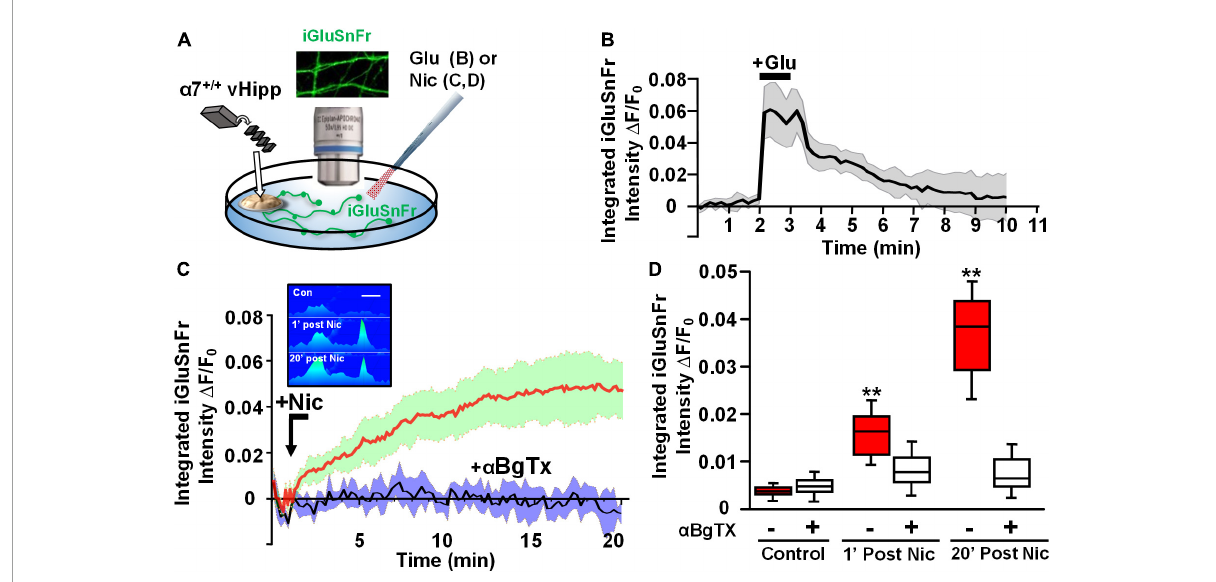
FIGURE5 Axonal α 7* nAChRs are required for nicotine-evoked glutamate release along ventral hippocampal projections. Nicotinic modulation of glutamatergic signaling along vHipp axons. (A) Schematic diagram of experimental configuration, see Section “Materials and methods.” In these studies, vHipp from individual WT ( α 7+/+) mice were plated as thinned micro explants in iGluSnFr (AAV9.hSyn. iGluSnFr.WPRE .SV40) containing culture media (see Section “Materials and methods”). After 7–10 days in vitro , iGluSnFr fluorescence signals along the vHipp axonal projections were recorded as an assay of glutamate release. Representative images of iGluSnFr expressing axons are shown. (B) iGluSnFr fluorescence intensities were calculated from spinning disk confocal images of α 7+/+ vHipp axons, collected every 10 s for 10 min and quantified as a normalized integrated intensity at each time point. The percentage changes in normalized integrated intensity at individual 1- µ m spots along vHipp axons were plotted vs. time. Traces from α 7+/+ vHipp axons are shown before, during and after glutamate-application (averaged of two recordings from two separate experiments). Application of exogenous glutamate (100 µ M, 1 min) increased iGluSnFr fluorescence intensity by ∼ 7%; this increase is maintained during glutamate application and decays to baseline over the next 5 min after glutamate wash out. Glutamate applications at lower concentrations did not show significant increase of iGluSnFr fluorescence intensities (data not shown). (C) Averaged traces of normalized iGluSnFr intensity along α 7+/+ vHipp axons before and after exposure to nicotine. Under normal conditions a 1 min exposure to nicotine elicited a robust increase in iGluSnFr signal along the vHipp axon, consistent with detection of local release glutamate (red line; SD = green shading, n = 20, 3). The effects of α BgTx treatment – which blocks all detectable nicotine induced iGluSnFr signal – is shown by the averaged traces in black (with SD shaded blue; n = 20, 3). Inset in (C) , representative spinning disk confocal iGluSnFr images recorded along the same axon segment before (top), 1 min after (middle), and 20 min after (bottom) nicotine (1 µ M, 1 min) application (pseudo color scale for release profile; inset scale bar 5 µ m). (D) Box plots of pooled data of iGluSnFr fluorescence intensity before and after acute nicotine application. Pre-incubation with α BgTx (100 nM, 5 min) had no detectable effect on iGluSnFr baseline (Control n = 20,3 vs. + α BgTx: 20, 3; p > 0.05). Nicotine